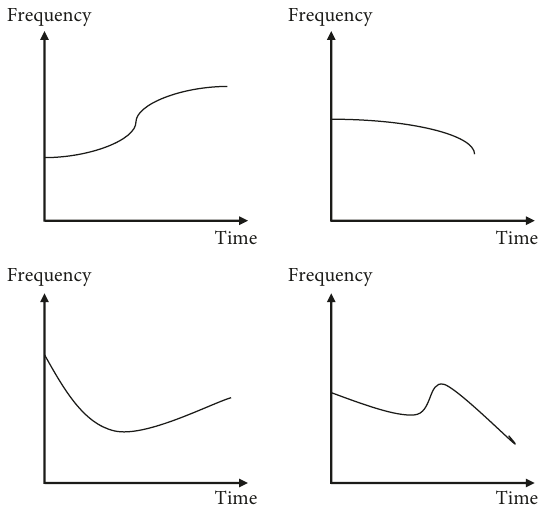
Figure 6: Main technical parameters of English speech